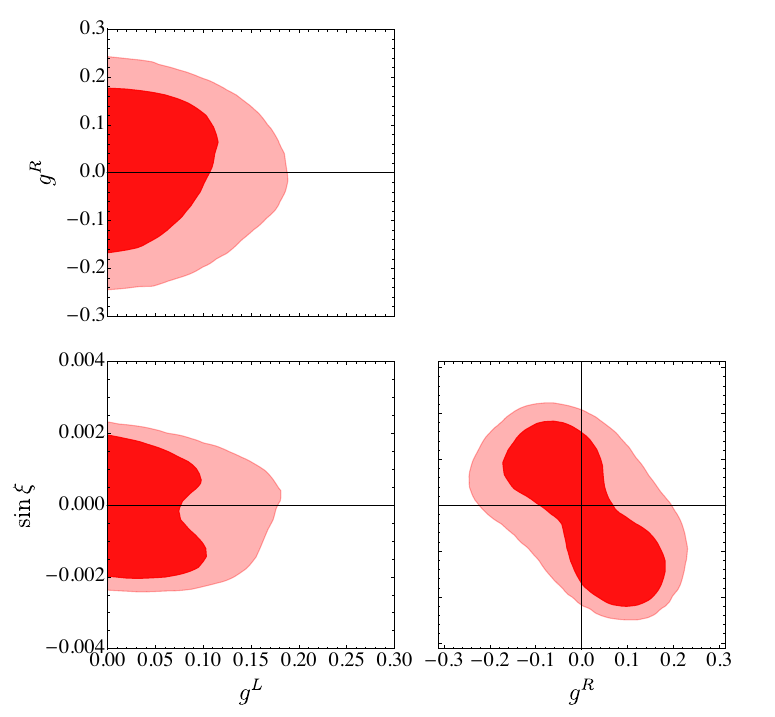
Figure 4. 68% and 95% CL regions for the three-dimensional LFU fit, where g L , g R and ξ are free parameters for M = 1 Z 0